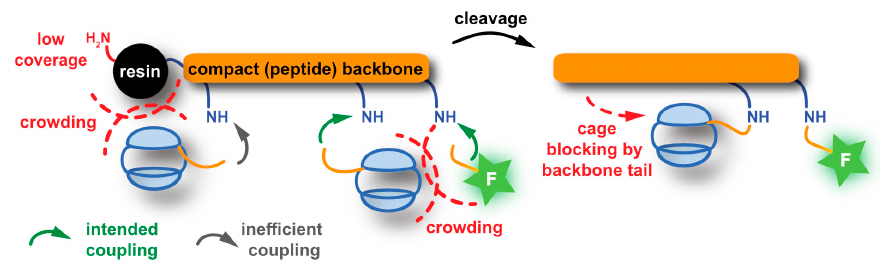
Figure 8. Generation of hosts for functionalized Xe on the solid support. Possible challenges (highlighted in red) include limited reactivity at intended coupling sites due to crowding at side chains when attaching bulky functional units such as CrA cages (blue) or fluorescent dyes (green); low coverage of the resin might be inevitable if coupling of such units is attempted too close to the resin; blocking of the cage through the peptide tail might occur after cleavage. Reprinted with permission from Bioconjugate Chem. 2018, 29, 12, 4004–4011 [195]. Copyright (2018) American Chemical Society.